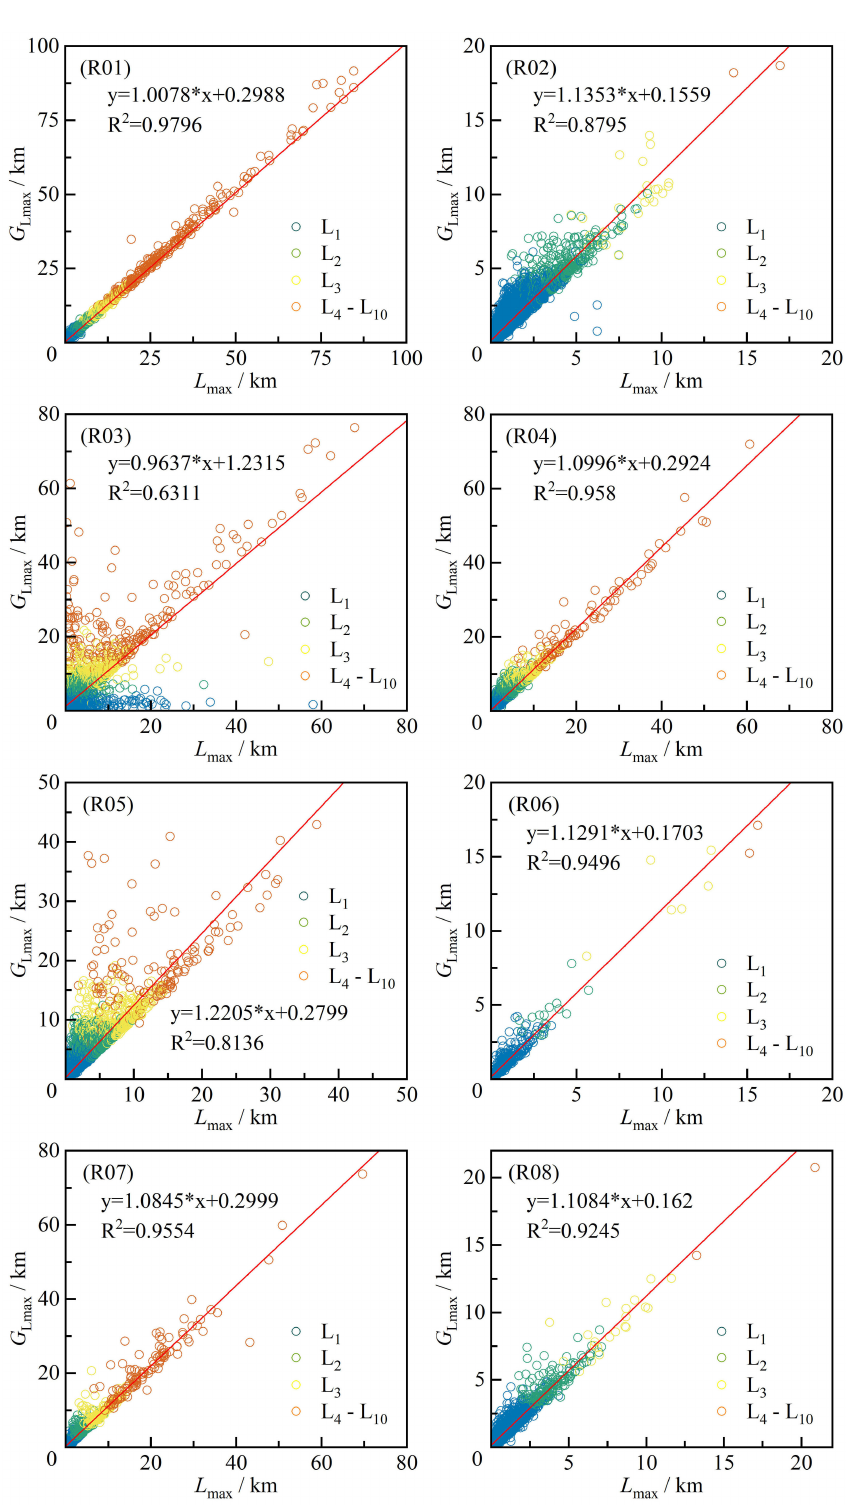
Earth Syst. Sci. Data, 14, 3889–3913,